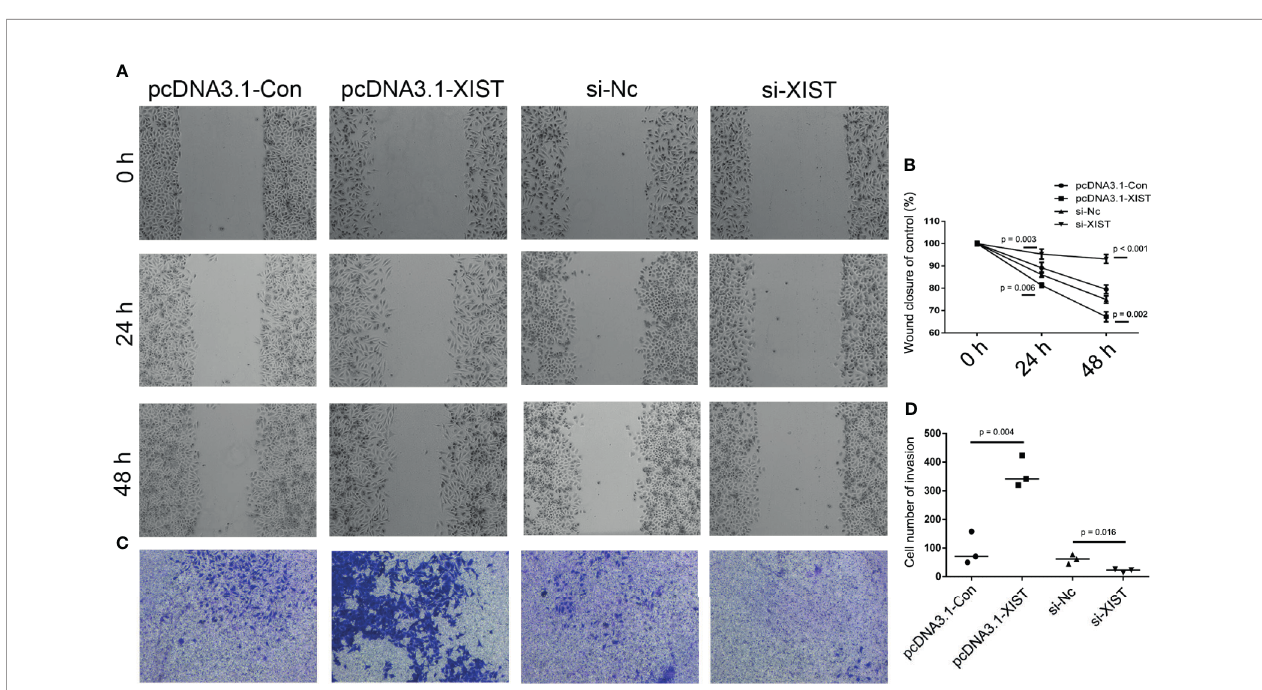
FIGURE 5 | Analysis of cell migration and invasion after XIST knockdown and overexpression. (A) Cell migration was assessed in the pcDNA3.1-Con, pcDNA3.1-XIST, si-Nc, and si-XIST groups in SCC9 cells to determine the effect of XIST on cell migration. (B) Statistical analysis of the percentage of cell migration among the four groups in 0 h, 24 h and 48 h. (C) Cell invasion was assessed in the pcDNA3.1-Con, pcDNA3.1-XIST, si-Nc, and si-XIST groups in SCC9 cells to determine the effect of XIST on cell invasion. (D) Statistical analysis of the percentage of cell invasion among the four groups. Statistical signi fi cances between groups were evaluated using t-test for independent